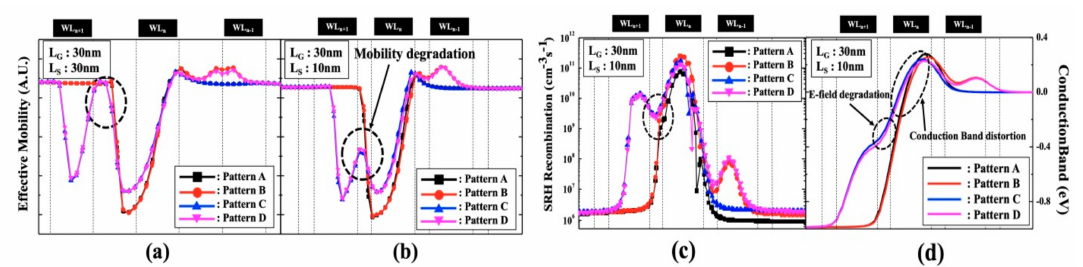
Figure 6. E ff ective mobility at the channel surface during the read operation ( a ) gate length 30 nm and space length 30 nm, ( b ) gate length 30 nm and space length 10 nm, ( c ) SRH (Shockley–Read–Hall) recombination at channel surface during the read operation at gate length 30 nm and space length 10 nm, ( d ) conduction band diagram at the channel surface according to each pattern at gate length 30 nm and space length 10